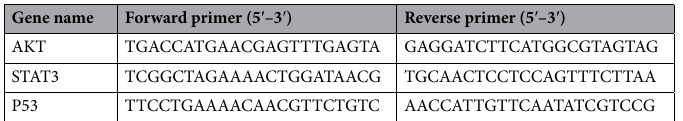
Table 4. The mRNA sequences of the targets obtained from the NCBI